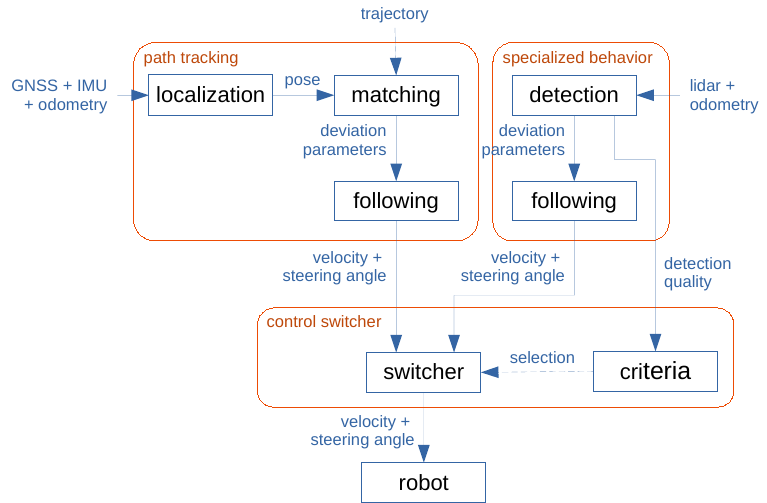
Figure 6. Description of the communication between the components of the selection